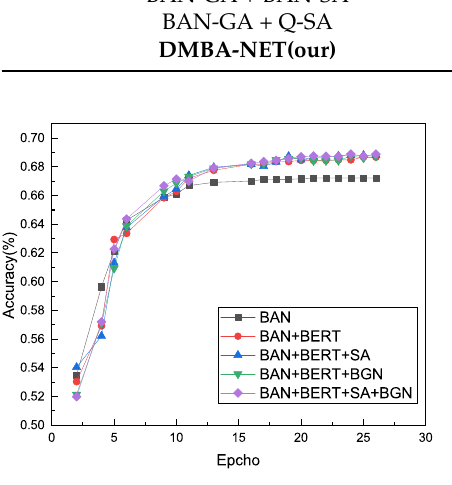
Figure 6. Accuracy curve of ablation model. The results are reported after using three random initialization.